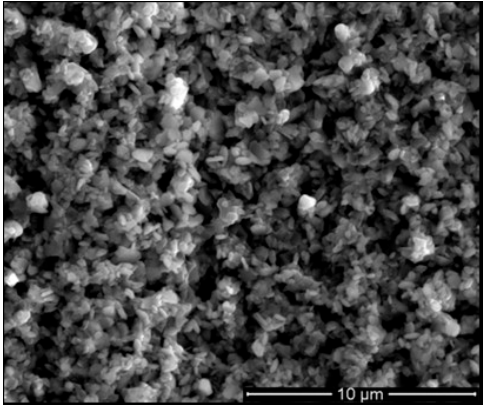
Figure 17. Top-down SEM image of Inconel 625 sample surface after 2500 h heating (10,000×).